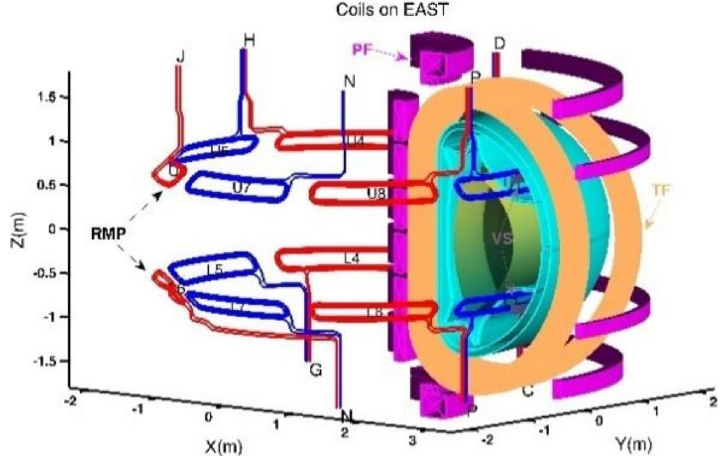
Fig. 9 RMP coils in the EAST tokamak (From Ref